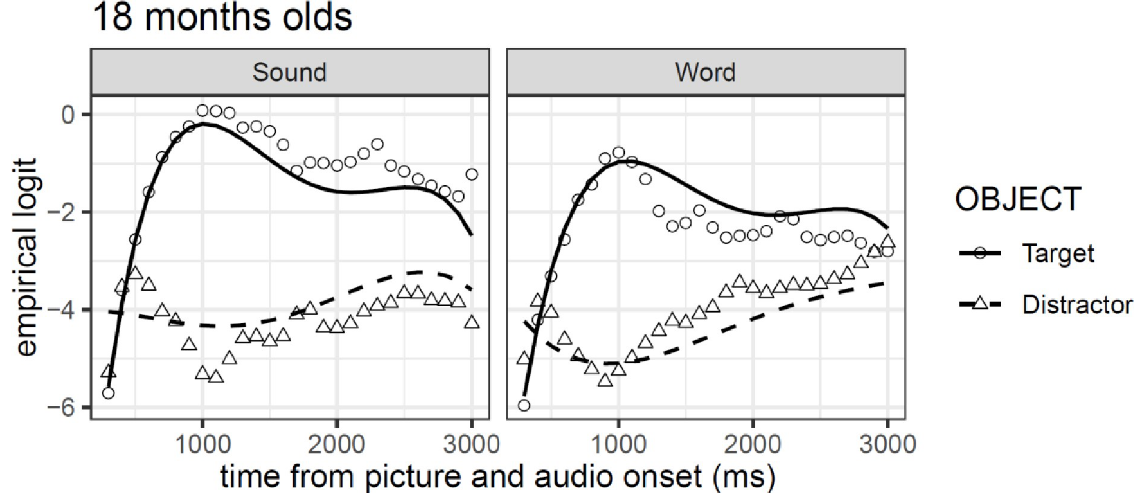
Fig 10. GCA model fit (lines) of empirical logit (points) as a function of object in the visual context and type of auditory stimulus in Experiment 2C.